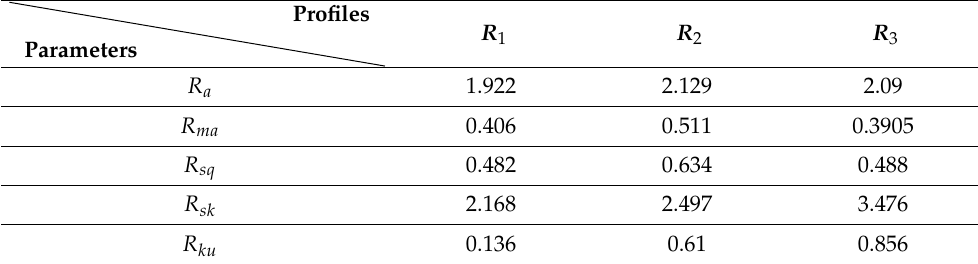
Figure 22. Boxplots for estimates of the fractal dimension from Gaussian random field samples with powered exponential covariance (16), using M = 5000 replicates for the three profiles: left R 1 , middle R 2 , right R 3 . Table 6. Classical roughness parameter estimates.